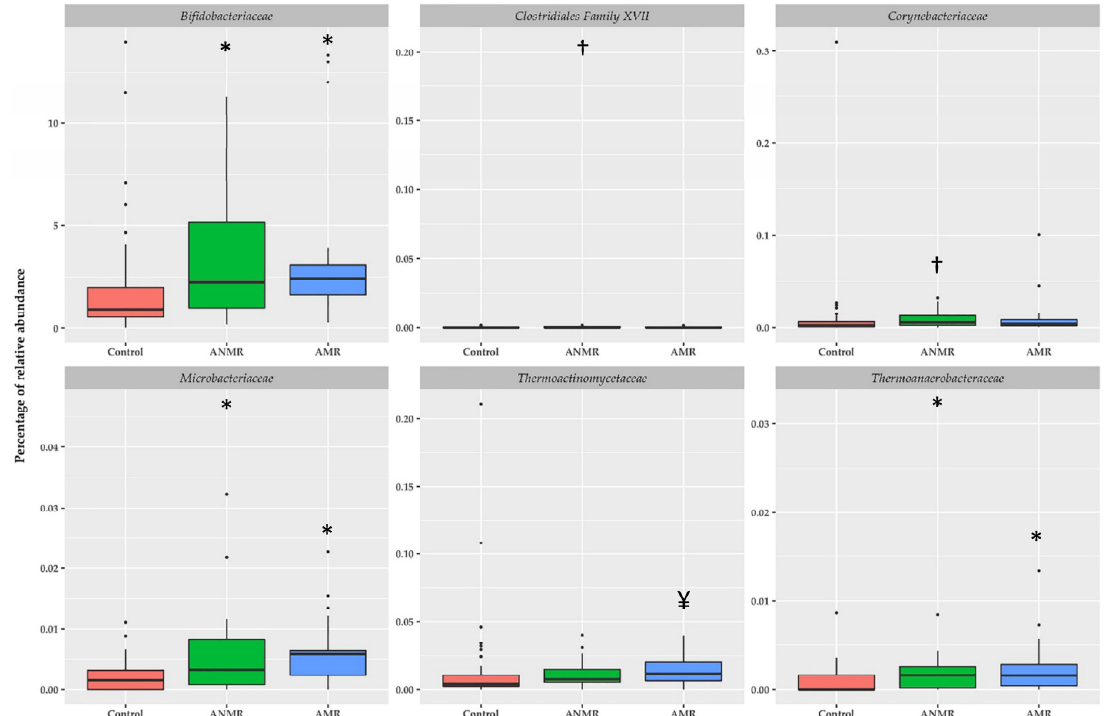
Figure 2. Relative abundances of selected bacteria according to family taxon in feces of children with ASD classified by mental regression and healthy children. Boxplots were generated using the R software utilizing the ggplot2 package and represent bacterial families * P < 0.05 vs. control group, † P < 0.05 vs. control and AMR groups, and ¥ P < 0.05 vs. control and ANMR groups using H Kruskal-Wallis test corrected by Bonferroni post-hoc test.